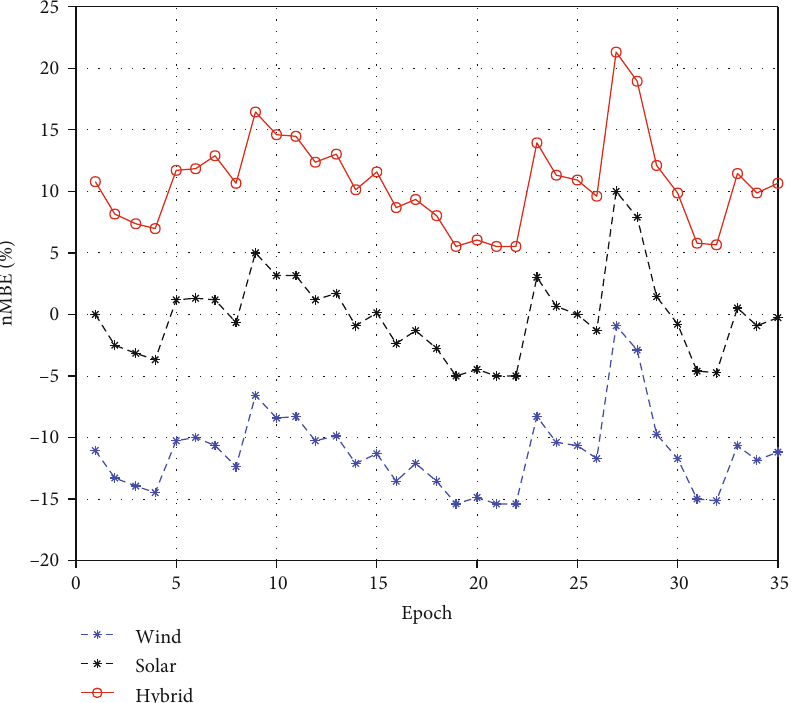
Figure 6: nMBE of all models.